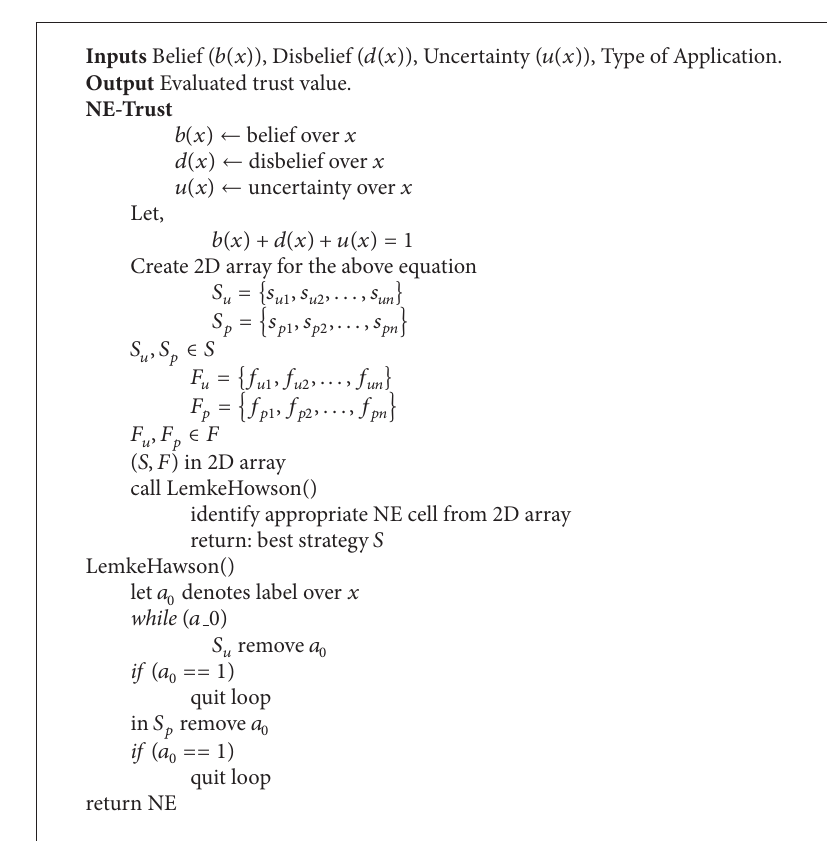
Algorithm 1: Pseudocode of the Nash equilibrium (NE) based trust